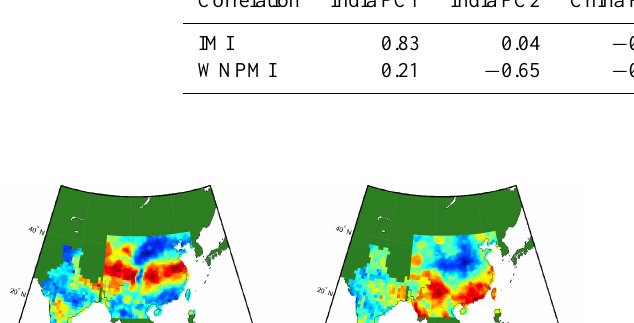
Table 1. Correlation coefficients between China/India rainfall PCs and monsoon indices (IMI & WNPMI). Correlation